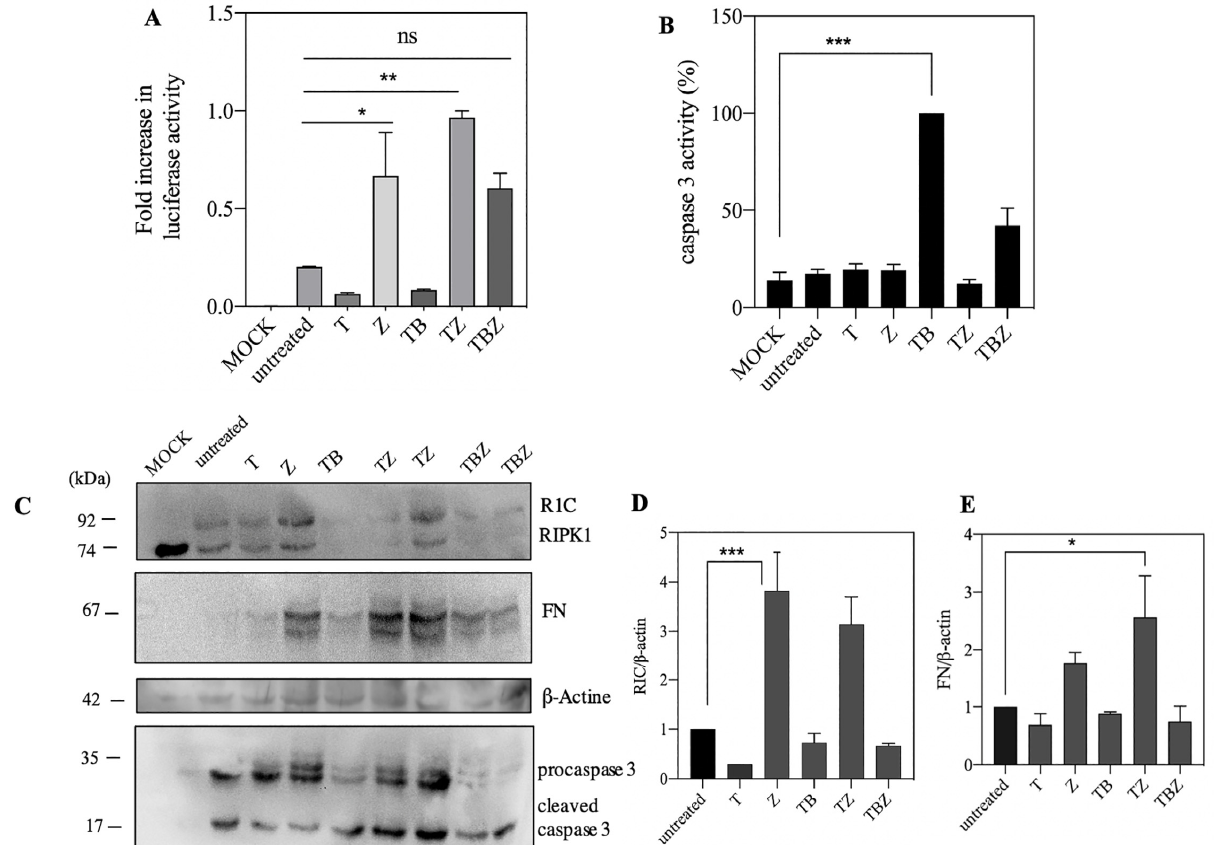
Figure 2. zVAD.fmk Promotes interaction between FADD and RIPK1. ( A ) SH-SY5Ycells were co- transfected with FN and R1C. Following transfection (24 h), cells were pre-treated by zVAD.fmk (25 µ M), BV6 (3 µ M) and after passing 1 h followed by stimulation with TNF α (100 ng/mL). ns, not significant; * p ≤ 0.05; ** p ≤ 0.01; *** p ≤ 0.001. ( B ) Caspase 3 activity applied with Ac-DEVD-AMC substrate of caspase 3 ( C ) expression of proteins was analyzed by western blotting. In the presence of TZ expression of RIPK1 and FADD were increased. However, TB did not increase protein expression ( D , E ) Relative expression levels of R1C and FN compared to β -actin were analyzed by ImageJ 1.53k, respectively.